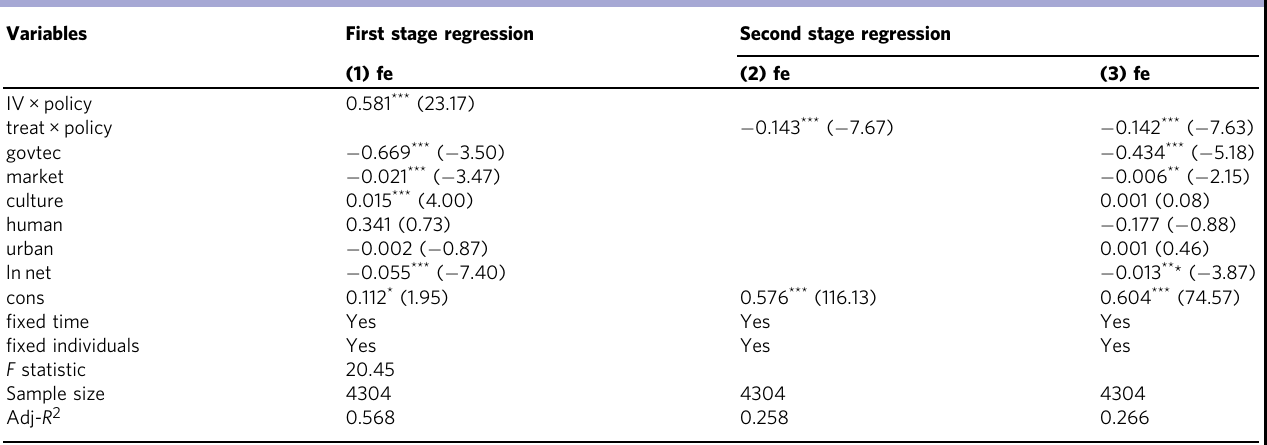
Table 4 Effect of the belt and road initiative on income disparity: result of IV regression.